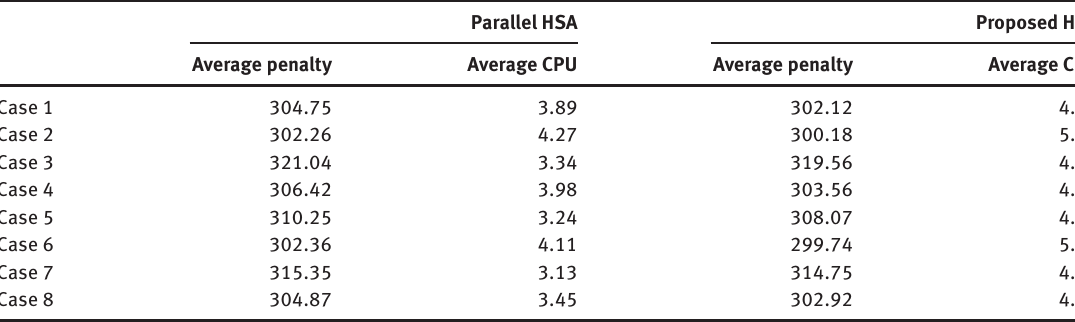
Table 9: Result of 5000 Iterations Obtained with Parallel HSA.